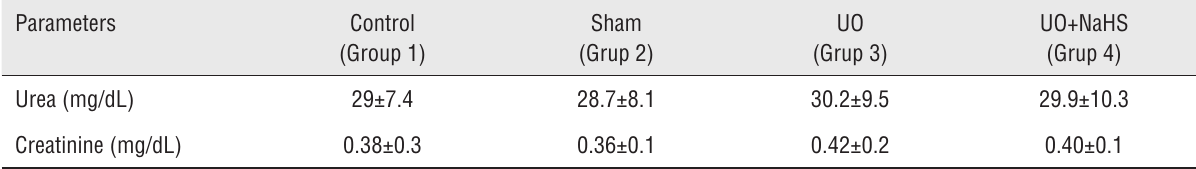
Table 1 - Effects of uuO alone and its combination with nahs on plasma urea, creatinine levels in rats. Parameters